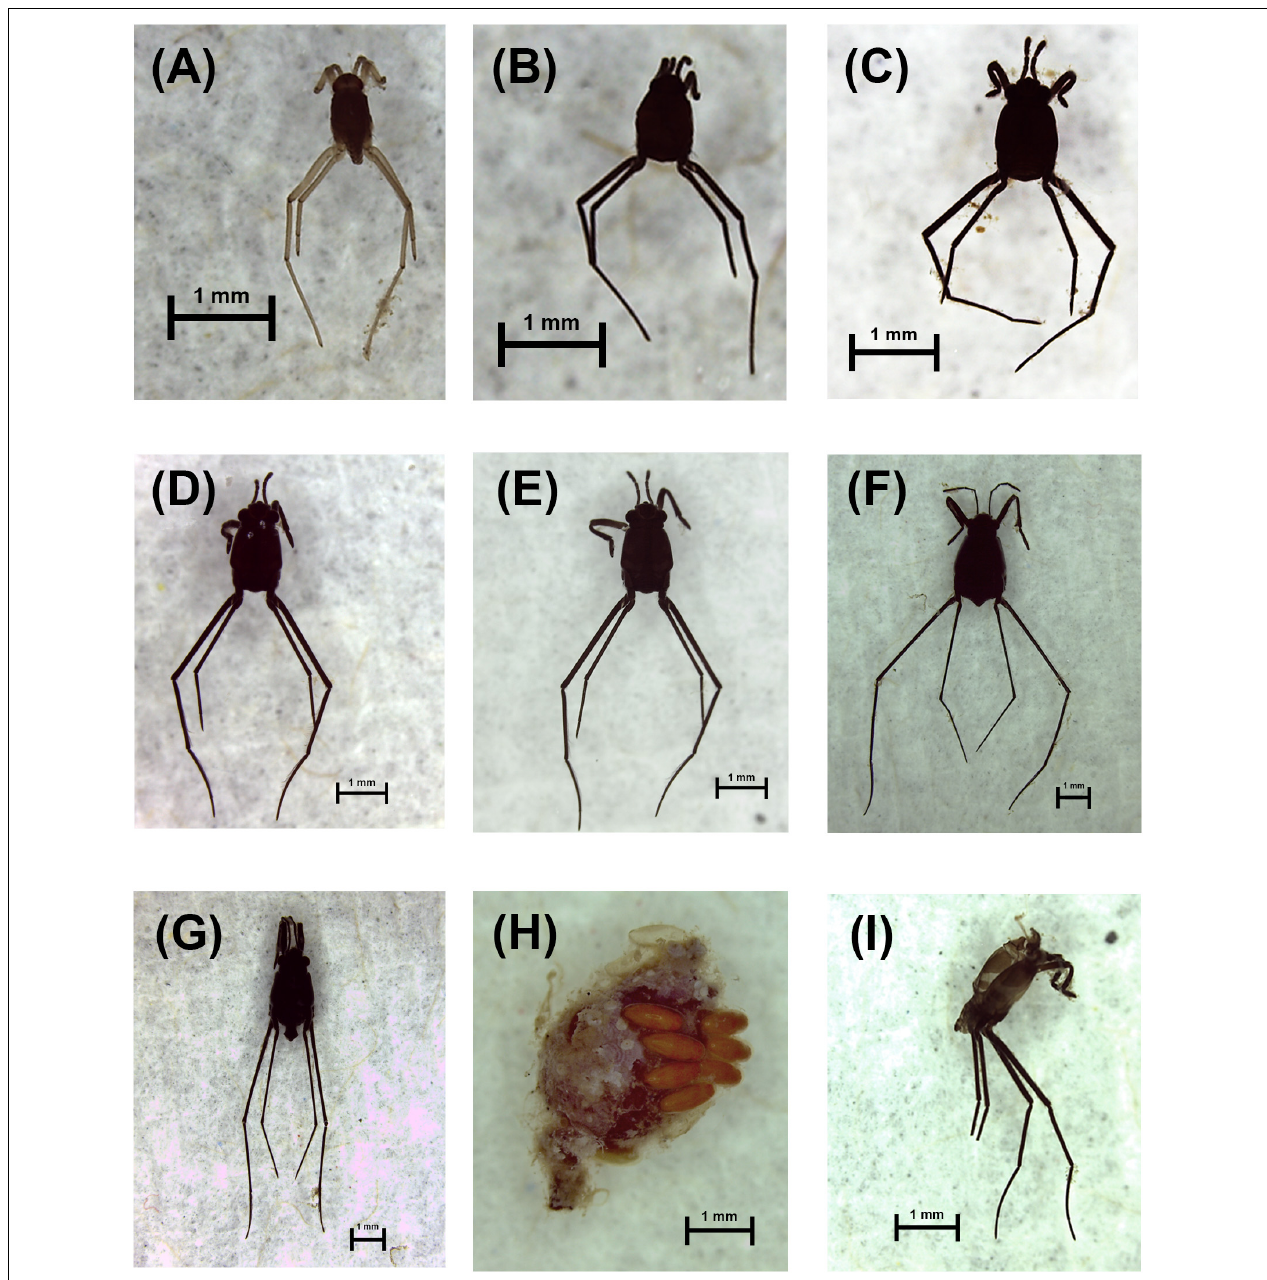
FIGURE 2 | Different stages of life cycle of Halobates germanus . (A–E) 1st to 5th instar stages, (F) adult female, (G) adult male, (H) eggs on Sargassum spp. pneumatocyst, and (I) exuviae. All scale bars = 1 mm.